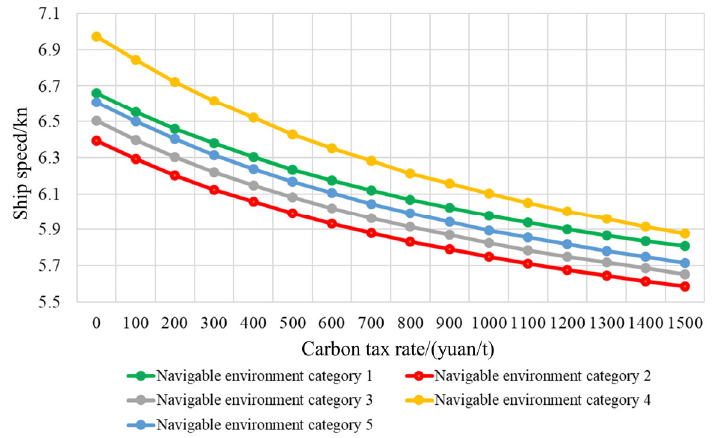
Figure 21. Optimal speed for each navigation environment under different carbon tax rates.